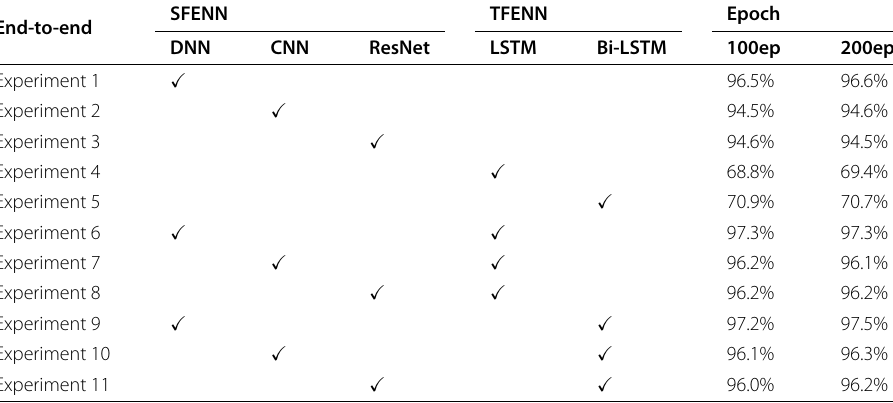
Table 6 Comparison and optimization experiment on network selection in PSTNN